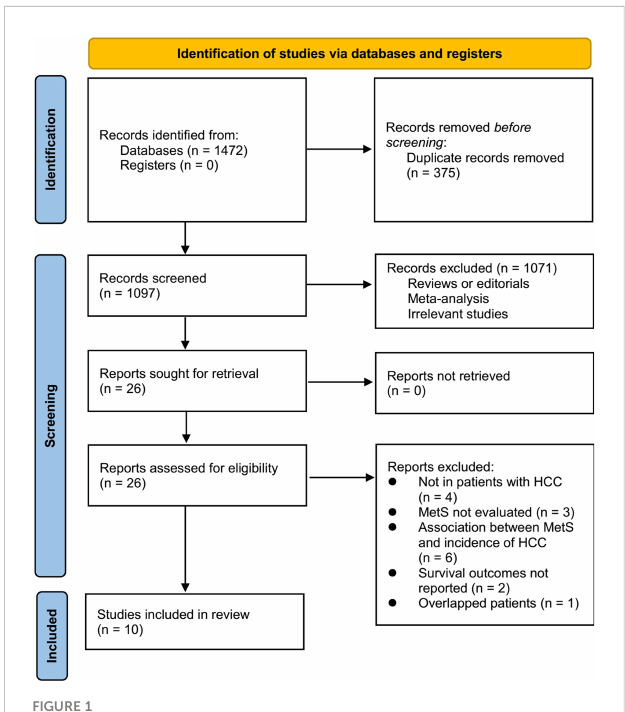
FIGURE 1 A summary of the literature search and study identi fi cation